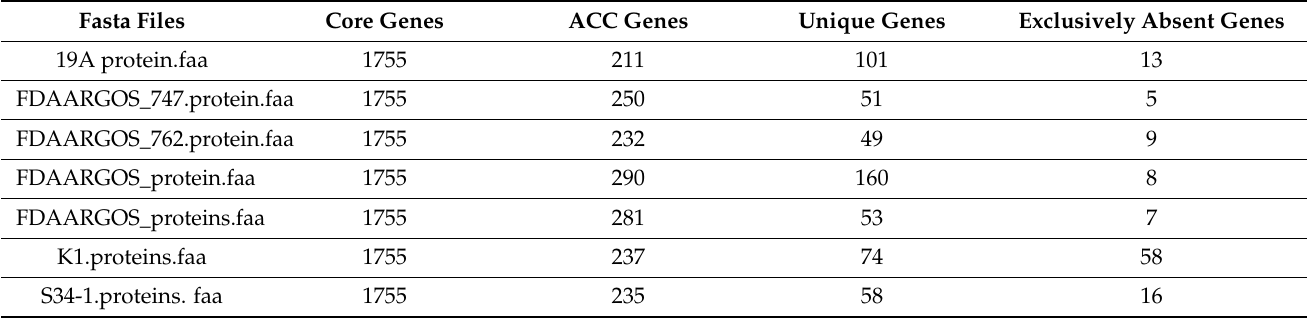
Table 2. Details of the pan-genome analysis. ACC (Accessory